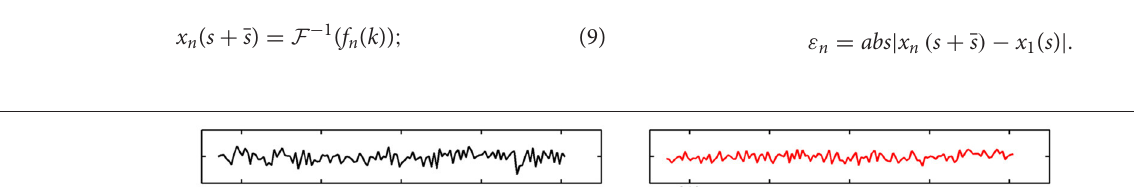
Frontiers in Physics |